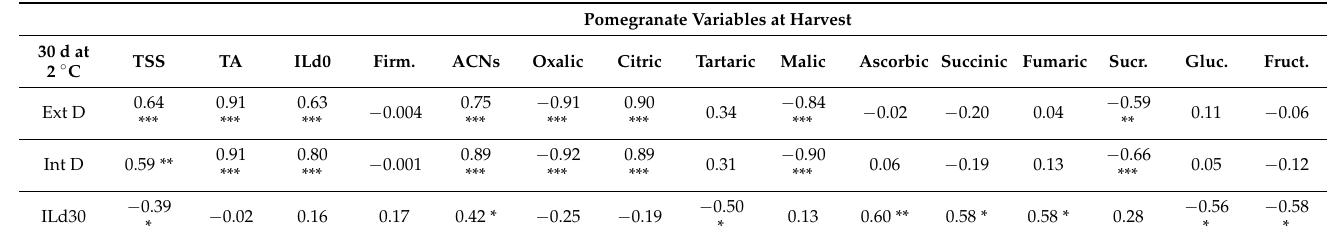
Table 3. Pearson correlation between dependent variables of fruit at harvest and external and internal damage of fruit storage for 30 d at 2 ◦ C plus 20 d at 20 ◦